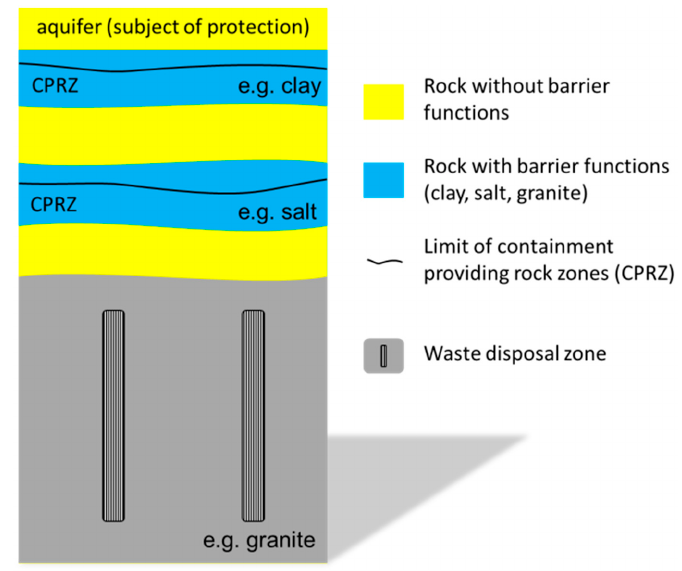
Figure 8. Possible containment-providing rock zones (CPRZ) for borehole disposal.